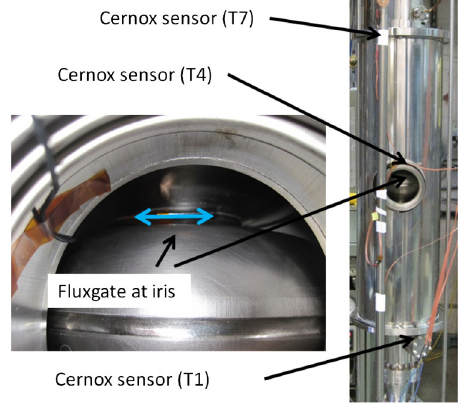
FIG. 6. Instrumentation during vertical testing of the fully dressed cavities. The fluxgate was located at the iris between cell 3 and 4, measuring the azimuthal field components. Also indicated are the positions of the thermometers.